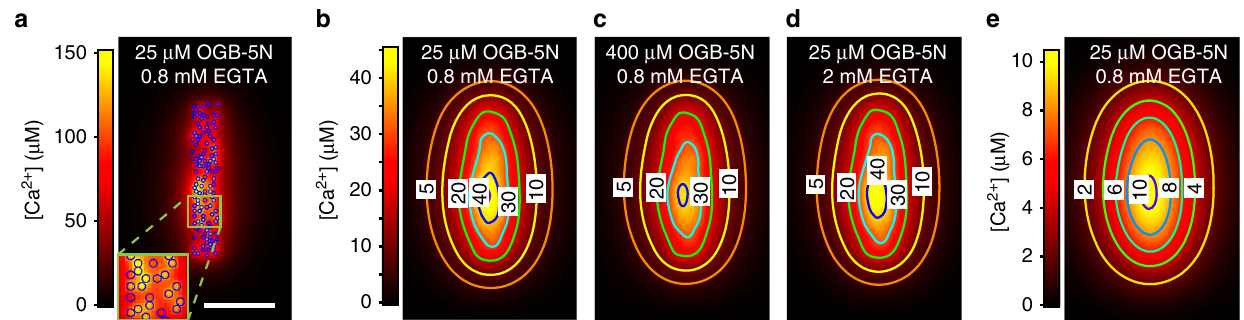
Fig. 5 Theoretical reaction/diffusion model of Ca 2+ at the IHC AZ. a Theoretical model of Ca 2+ in fl ux at a 430 nm × 67 nm cluster of 120 Ca 2+ channels (blue symbols, width of 10 nm) shows that the local increase in free [Ca 2+ ] near the channel mouth, before the Ca 2+ ions bind to the Ca 2+ -indicator or the non- fl uorescent buffers, can reach values as high as 150 µ M. Blue symbols indicate the positions of simulated Ca 2+ channels. Inset shows a magni fi cation of the area marked by the green square. Scale bar: 100 nm. b [Ca 2+ ], as calculated from the simulated distribution of OGB-5N at the synapse ( “ reported [Ca 2+ ] ” ), reaches peak values of 45 µ M. The lateral diffusion of Ca 2+ ions and buffers makes it impossible to acquire the [Ca 2+ ] at the channel mouth and results in an elongated Ca 2+ domain. Numbers indicate the [Ca 2+ ] at the contour lines. c Increasing the simulated [OGB-5N] (here to 400 µ M) results in a lower reported peak [Ca 2+ ] of ~40 µ M. d Increasing the simulated [EGTA] (here to 2 mM) results in a reported peak [Ca 2+ ] of ~44 µ M. e Same data as in b , but additionally convolved with a Gaussian PSF with a FWHM of 64 × 64 × 542 nm, mimicking 2D-STED imaging. The reported [Ca 2+ ] after convolution reaches peak values of up to 10 µ M, still considerably lower than the actual concentration near the ≪ [OGB-5N]) evoked somewhat larger Ca 2+ hotspots than observed under “ physiological ” conditions.